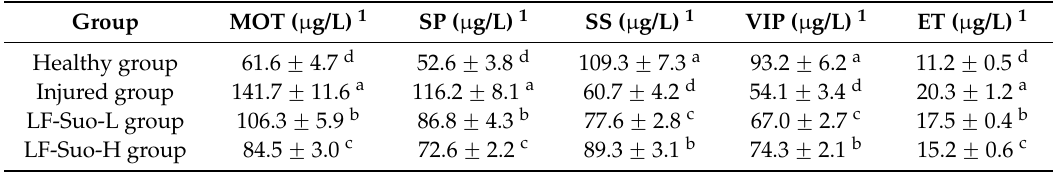
Table 4. Serum MOT, SP, SS, VIP and ET levels in studied mice.